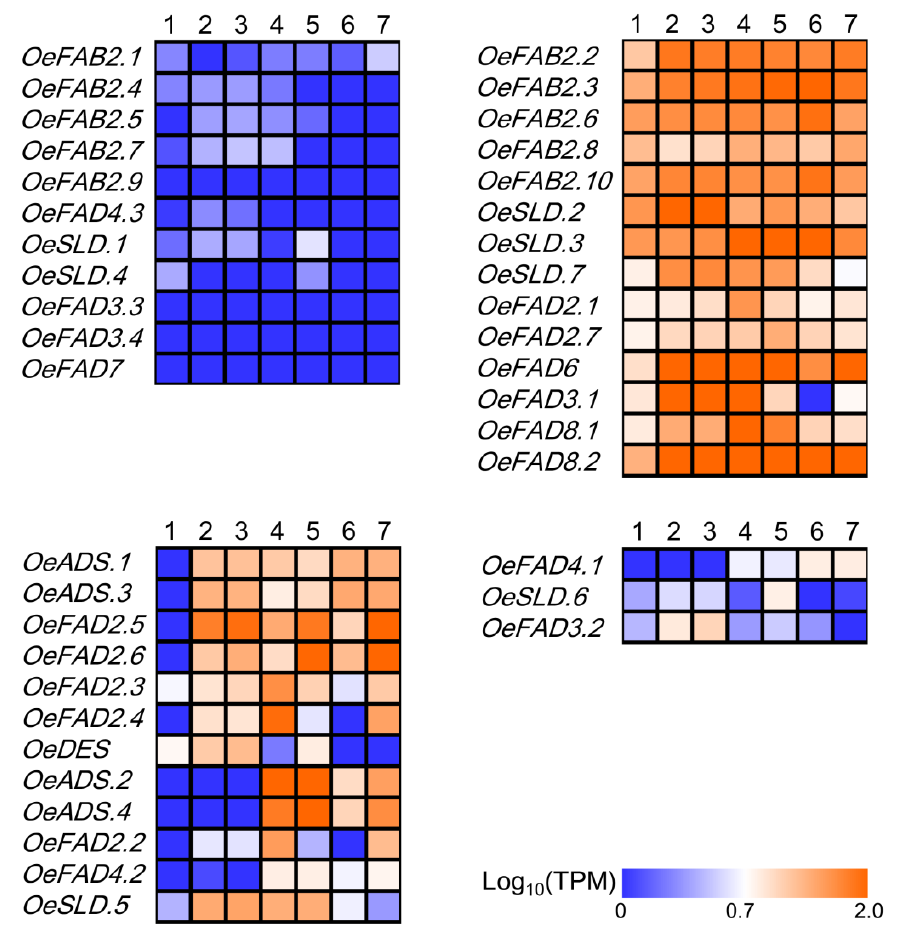
Figure 3. Different tissue expression profiles of FAD genes in olive. Transcriptome data of different tissues (PRJEB4992) were obtained from NCBI and included five tissues recorded as 1: roots, 2/3: leaves (young/old), 4: flowers, 5: flower buds, 6/7: fruits (green/immature). The log 10 (TPM) was calculated as the expression level. TPM, Transcripts Per Million. Four expression patterns of FAD genes in olive morphology were shown including the genes with TPM <5.0 in all five tissues, genes with TPM ≥ 5.0 in five tissues, genes with TPM ≥ 5.0 in two, three or four tissues and genes with TPM ≥ 5.0 in single